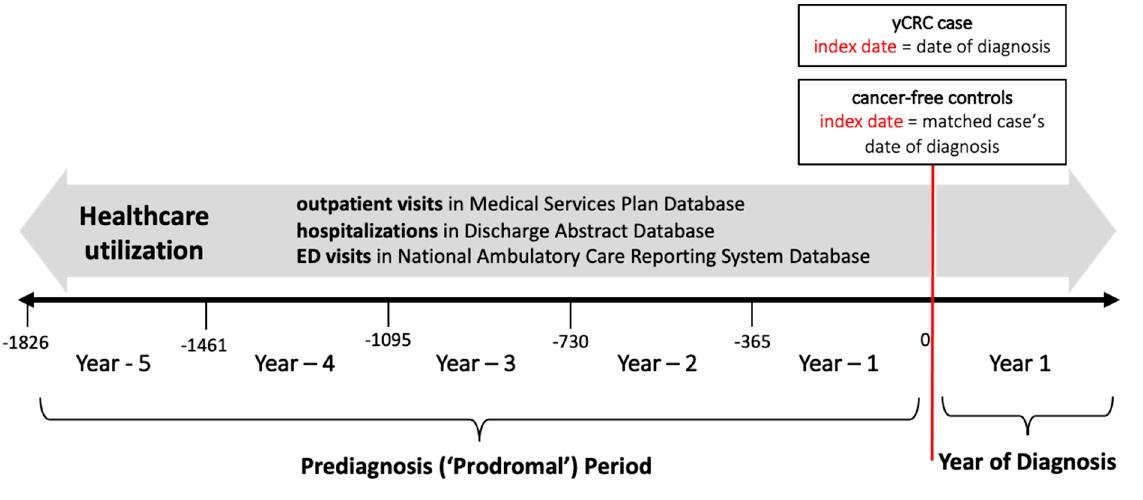
Figure 1. Schematic of study design in timing of assessment of patterns and cohort selection of healthcare utilization.